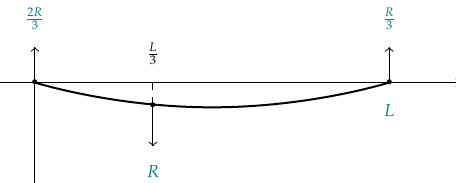
Figure 8. Concentrated load at one third of its